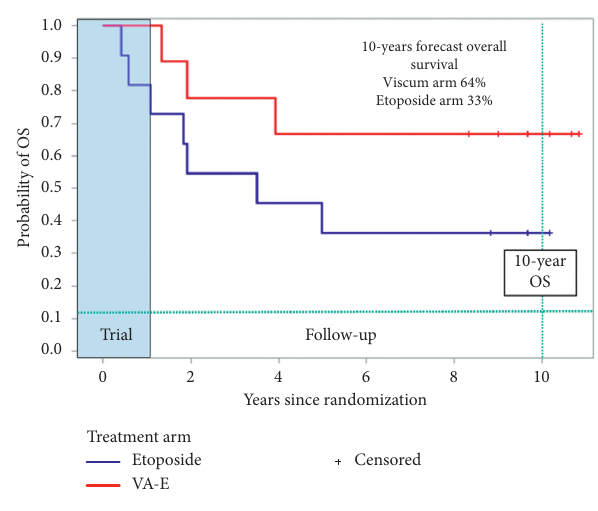
Figure 2: Overall